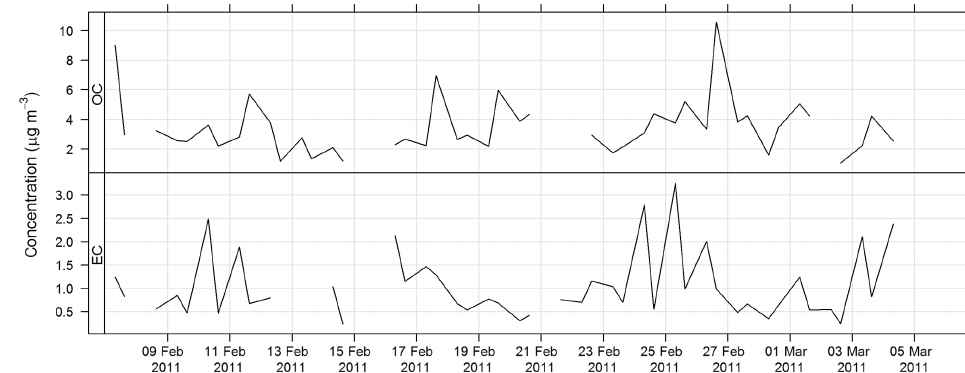
Figure 17. Time series of OC and EC during SPS-I in 2011.